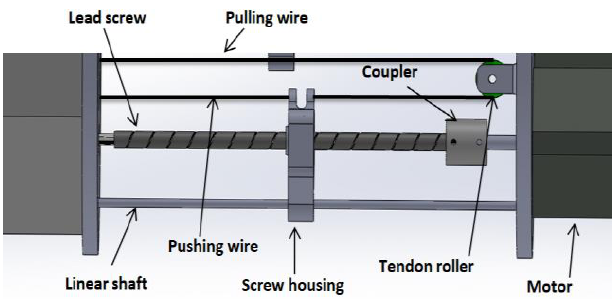
Figure 3. TakoBot wire-actuating unit.